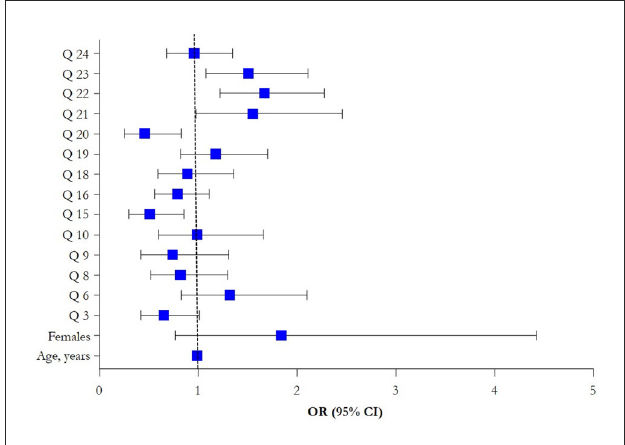
FIGURE1 Forest plot of multivariate logistic regression results (OR, 95%